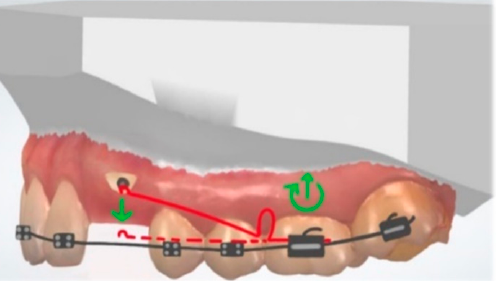
Figure 5. Cantilever with a loop activated for buccally impacted canine extrusion (red: cantilever, green: force and moment).